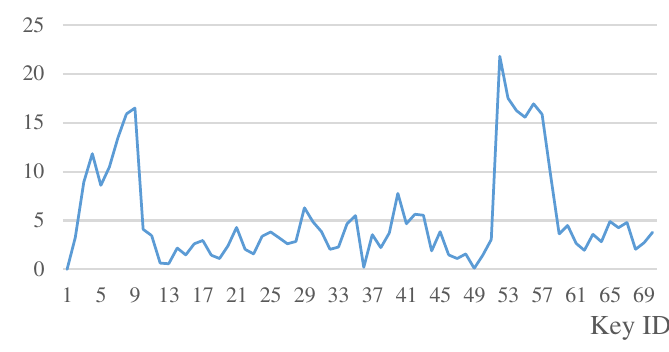
Figure 16. Experiment 2: errors at each keypoint. Table 4. Experiment 2: error